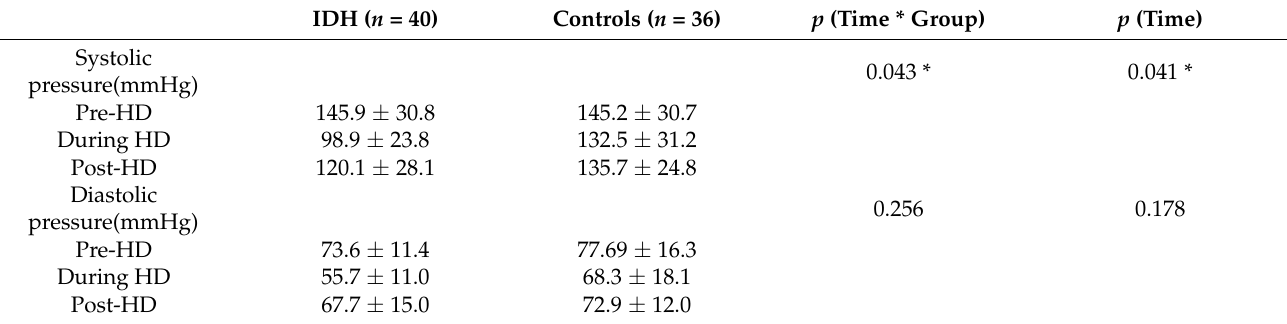
Table 2. Hemodynamic parameters during hemodialysis session between two